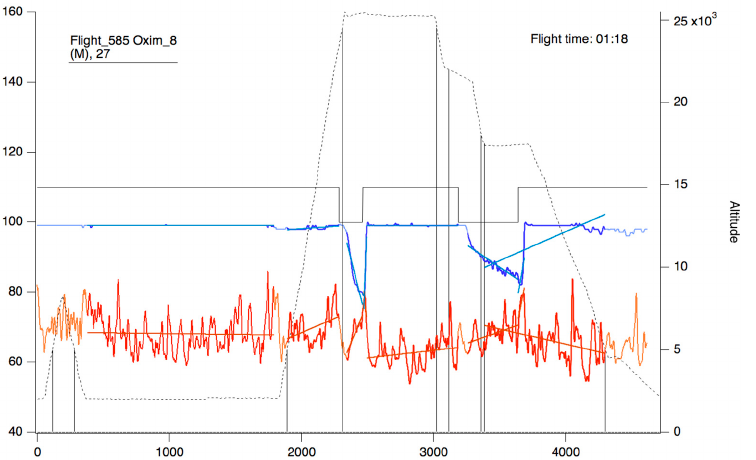
Figure 9. Oxygen saturation curve (blue/sky blue) and heart rate (red/orange). The continuous black line represents the state of connection/reconnection to oxygen. The dashed line represents the flight profile. The lines that appear as a weaker color (light blue/orange) represent the slopes that were calculated for the area of the curve that presents as a more intense color (blue/red).